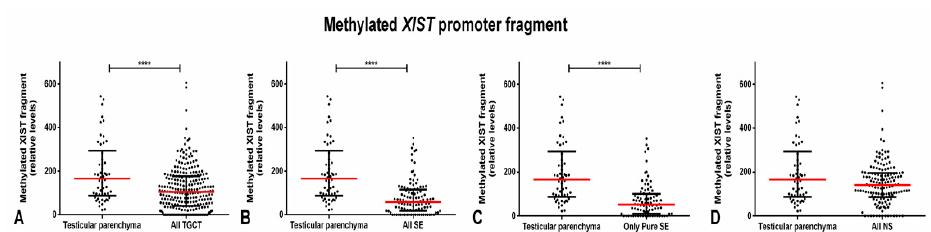
Figure 1. Methylated XIST fragment relative amounts in testicular germ cell tumors and testicular parenchyma of the discovery cohort. Relative amounts of the methylated XIST fragment among testicular parenchyma samples and ( A ) all testicular germ cell tumors (TGCTs), ( B ) all seminomas (SEs), ( C ) only pure SEs, and ( D ) all non-seminomas (NSs). **** indicate p < 0.0001. Abbreviations: